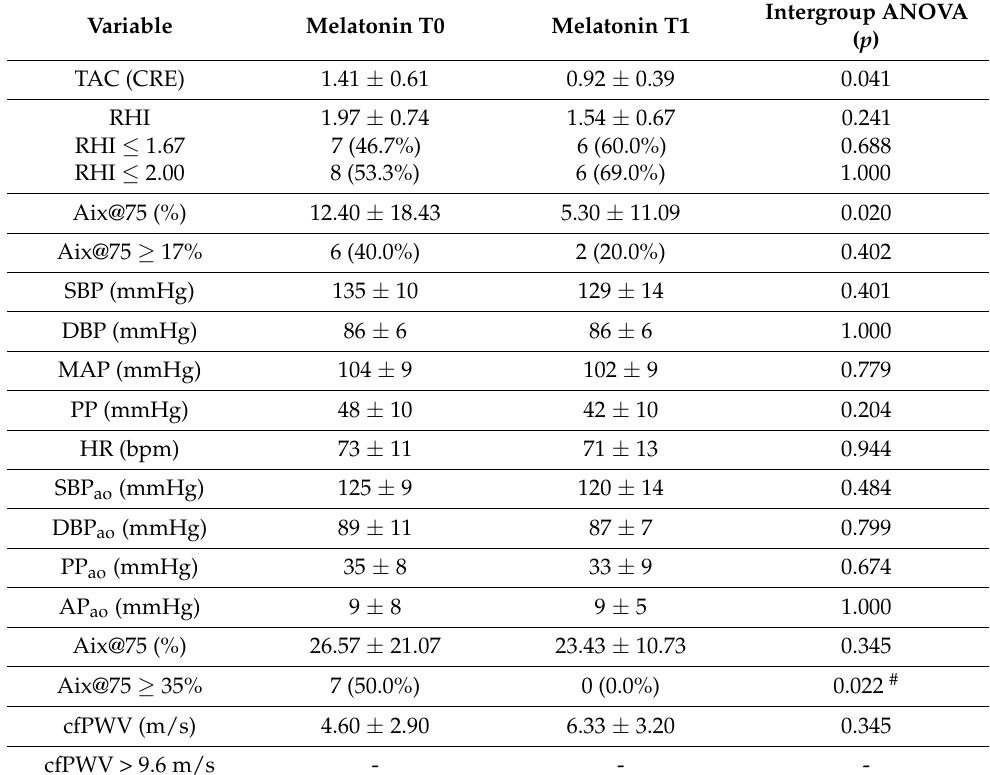
Table 4. Schematic representation of the comparison of the different variables studied, within the melatonin group, at T0 and T1. # p < 0.05 vs. Melatonin T0 group. Data are expressed as mean ± standard deviation